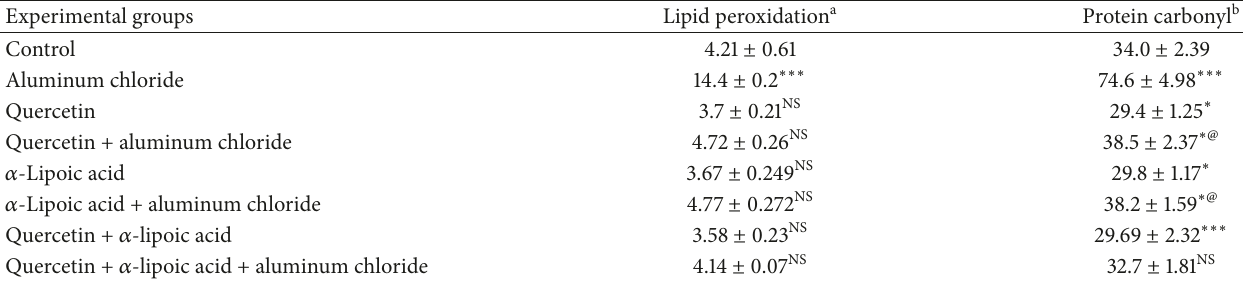
Table 1: Effect of aluminum chloride, quercetin, and 𝛼 -lipoic acid (ALA) treatment on oxidative stress indices in rat brain.